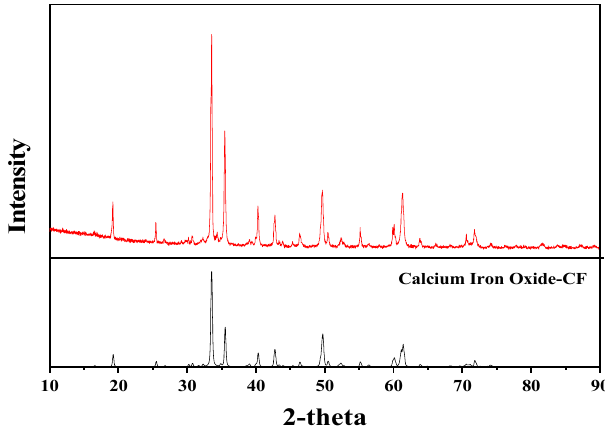
Figure 5. X-ray diffraction ( XRD) patterns of samples and CaO-Fe 2 O 3 in standard PDF card.